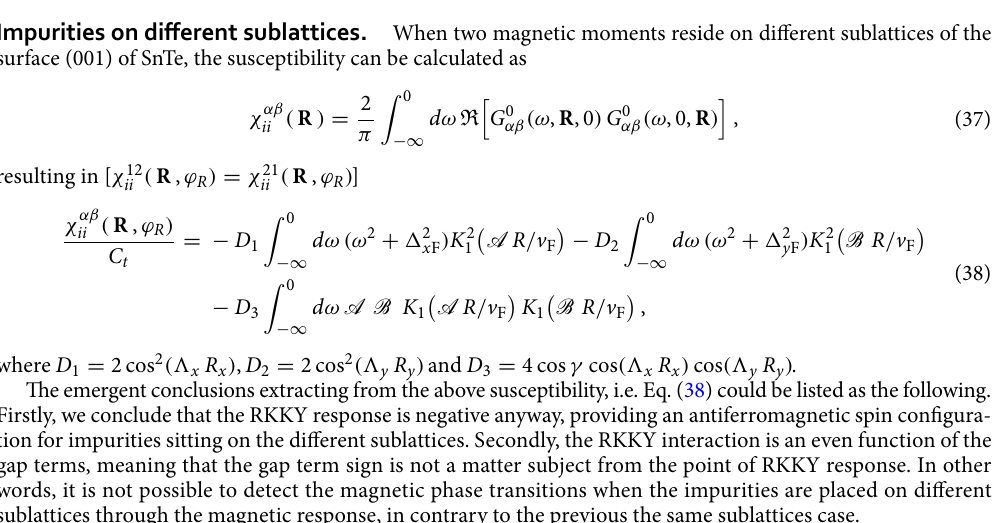
( R , ϕ R )/ J 2 C t as a function of ϕ R at fixed R J RKKY αβ −